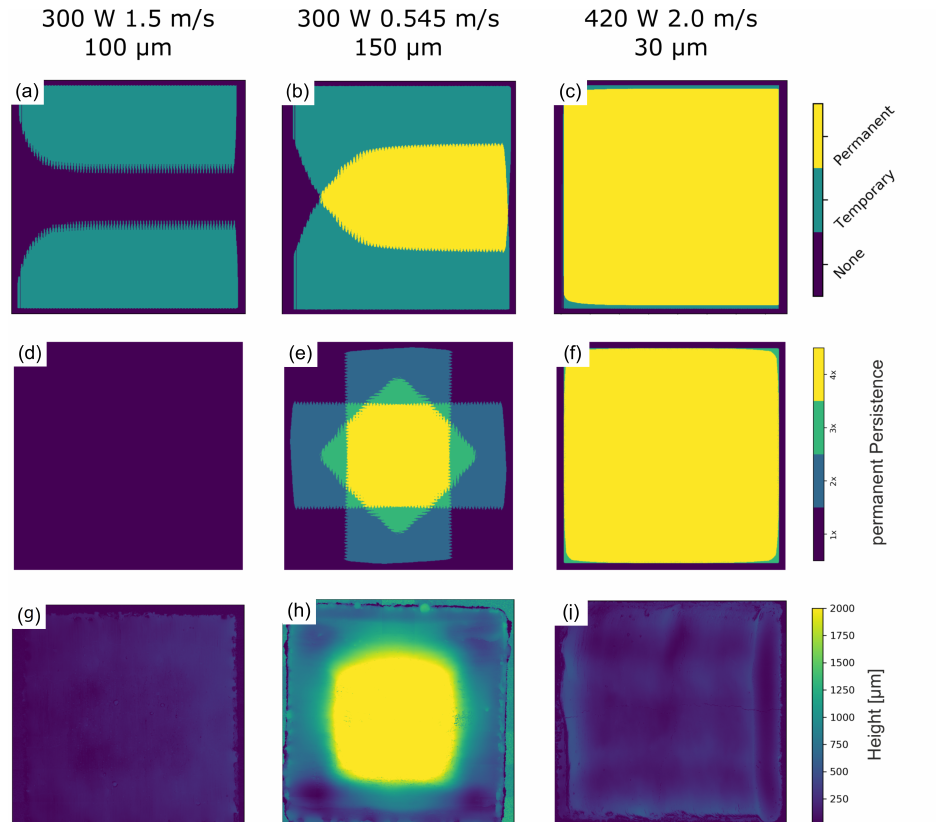
Figure 6. Persistence formation according to numerical simulation and the resulting surface topogra- phy for 500 consecutive layers with 90° hatch rotation. ( a – c ) predicted persistence for one individual layer with lateral melt direction from left to right. ( d – f ) predicted permanent persistent regions according to superposition due to a 90° scan rotation. ( g – i ) experimentally observed CMSX-4 surface topography according to laser scanning